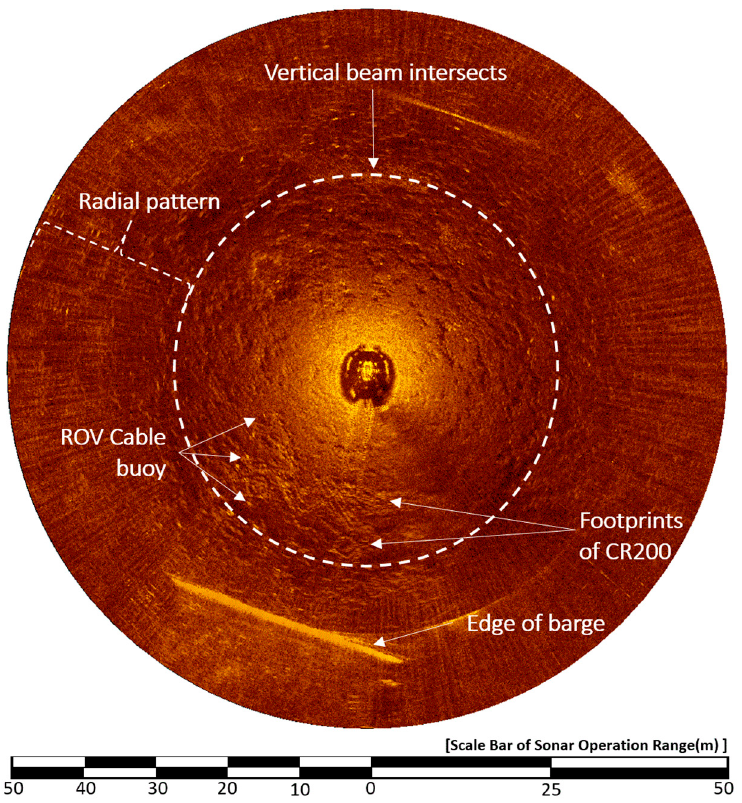
Figure 19. Result image of the 10° downward HHM.